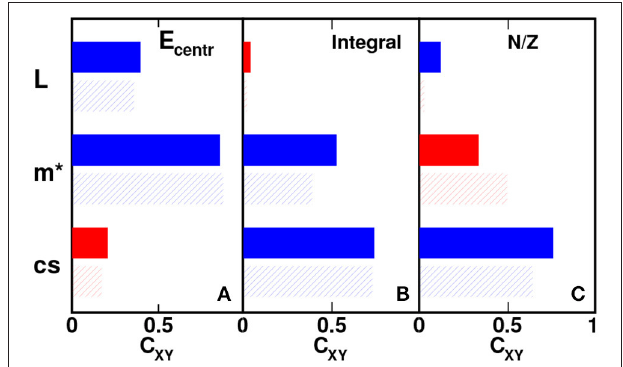
FIGURE 11 | (Color online) Negative (positive) correlations functions between model parameters and observables are indicated by blue (red) bars. Solid and shaded bars refer to different sets of calculations included in the analysis (see text for more details). Readapted from Zheng et al. [40]. The centroid of the DD emission strength, its integral and the N/Z ratio of the nucleons emitted are considered in (A–C) , respectively.